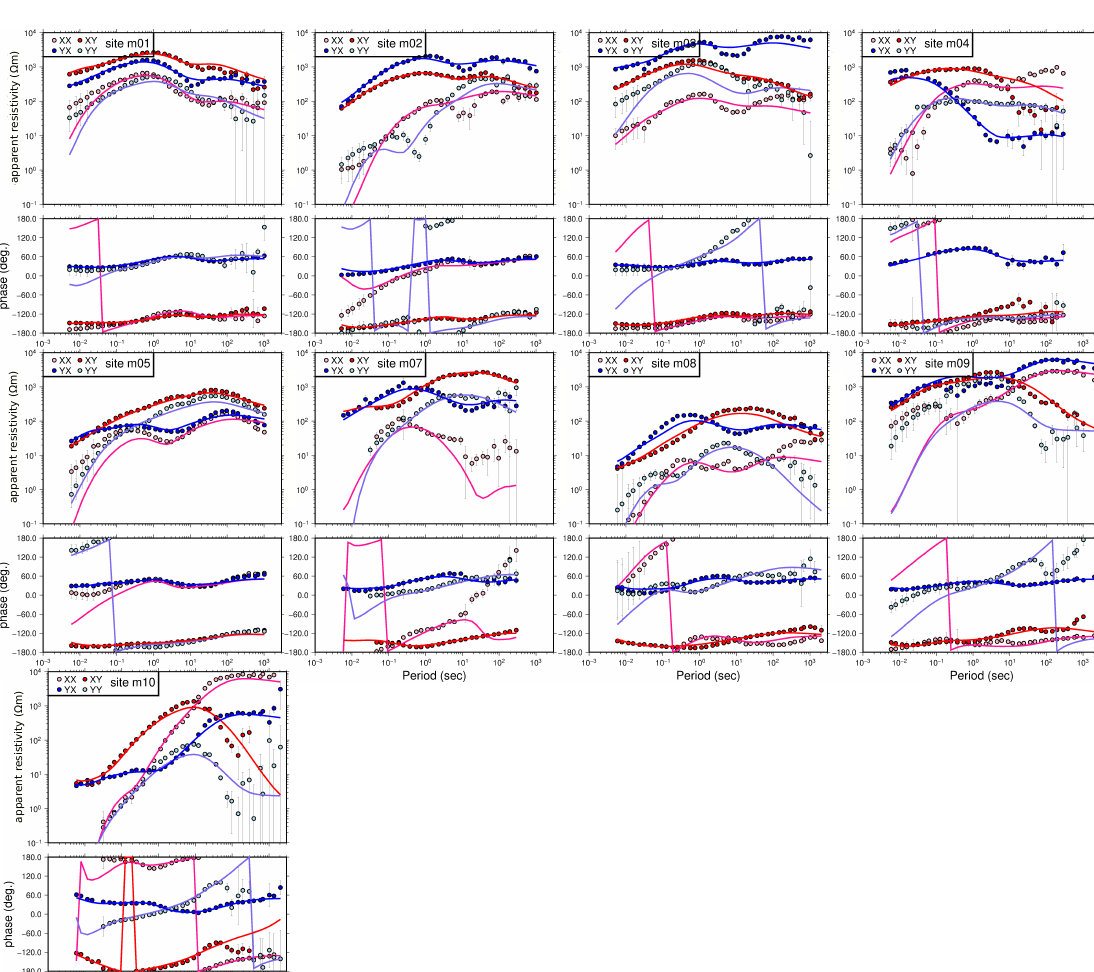
Figure A4. MT impedance tensor for all southern profile sites (see Figure 1B for location). The four complex tensor components are Z xx (pink), Z yy (cyan), Z xy (red) and Z yx (blue) shown as apparent resistivity and phase (dots). The error bars are one standard deviation. Full lines correspond to the response of the best 3-D model. See text for